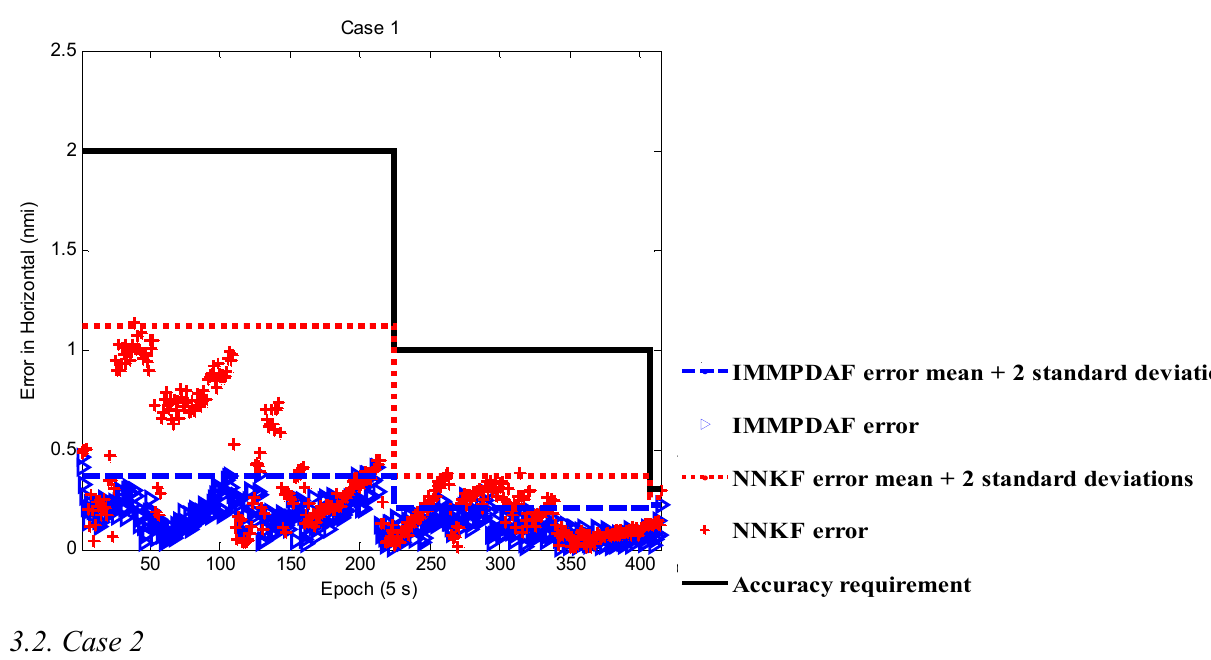
Figure 3. Performance of IMMPDAF and NNKF for Case